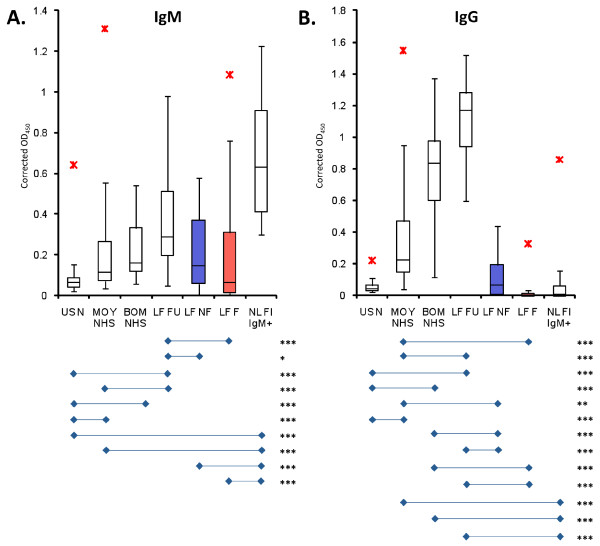
IgM and IgG responses for normal donors, LF and NL febrile subjects. Box plots of LASV-specific IgM (A) and IgG (B) levels determined by ELISA, are displayed as mean OD450 with corrected cutoff values based on the 95th percentile of established negative control sera. Each display shows the minimum non-outlying value, three quartiles, maximum non-outlying value, and outlying values. The comparison groups include U.S. normals (US N), Moyamba district normals (MOY NHS), Bombali district normals (BOM NHS), convalescent LF follow-up patients (between 8 and 108 weeks post discharge [LF FU]), nonfatal acute LF cases (LF NF), fatal LF cases (LF F), and non-Lassa febrile illness with LASV-specific IgM only (NL FI IgM+). IgM and IgG levels for patients in the LF FU sera group were significantly higher than those in for all of the other comparison groups, save for those in the BOM NHS and NL FI IgM+ cohorts. There were no significant differences between LF NF and LF F cases for both IgM and IgG responses. Bombali sera showed relatively high levels of LASV-specific IgM and IgG, but these levels did not significantly differ from those for LF FU patients, despite their undiagnosed recent LF or other febrile illnesses. Outliers are indicated with red asterisks (*). Significant p values for pairwise comparisons are displayed as * p < 0.05; ** p < 0.01; and *** p < 0.001.